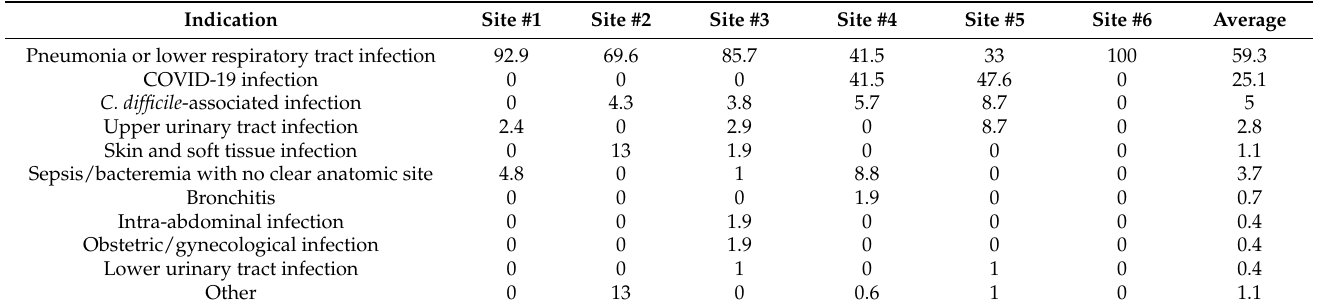
Table 3. The most common indications for therapeutic antibiotics (ATC J01, P01AB, A07AA) in patients in COVID-19 wards, %.